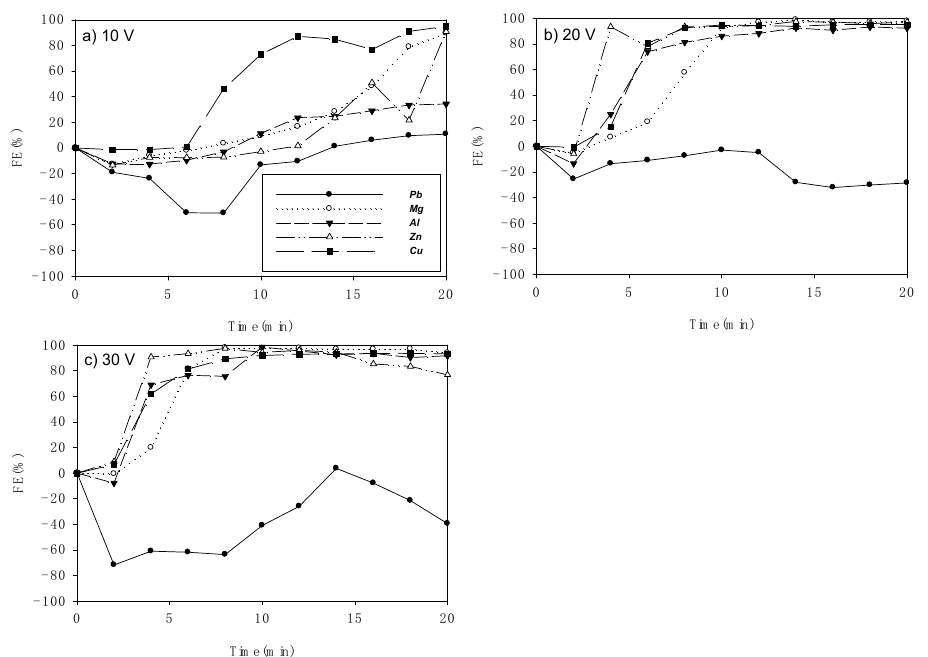
Figure 2. Effect of voltage on the flocculation efficiency of Pb, Mg, Al, Zn, and Cu electrodes at ( a ) 10 V, ( b ) 20 V, and ( c ) 30 V.